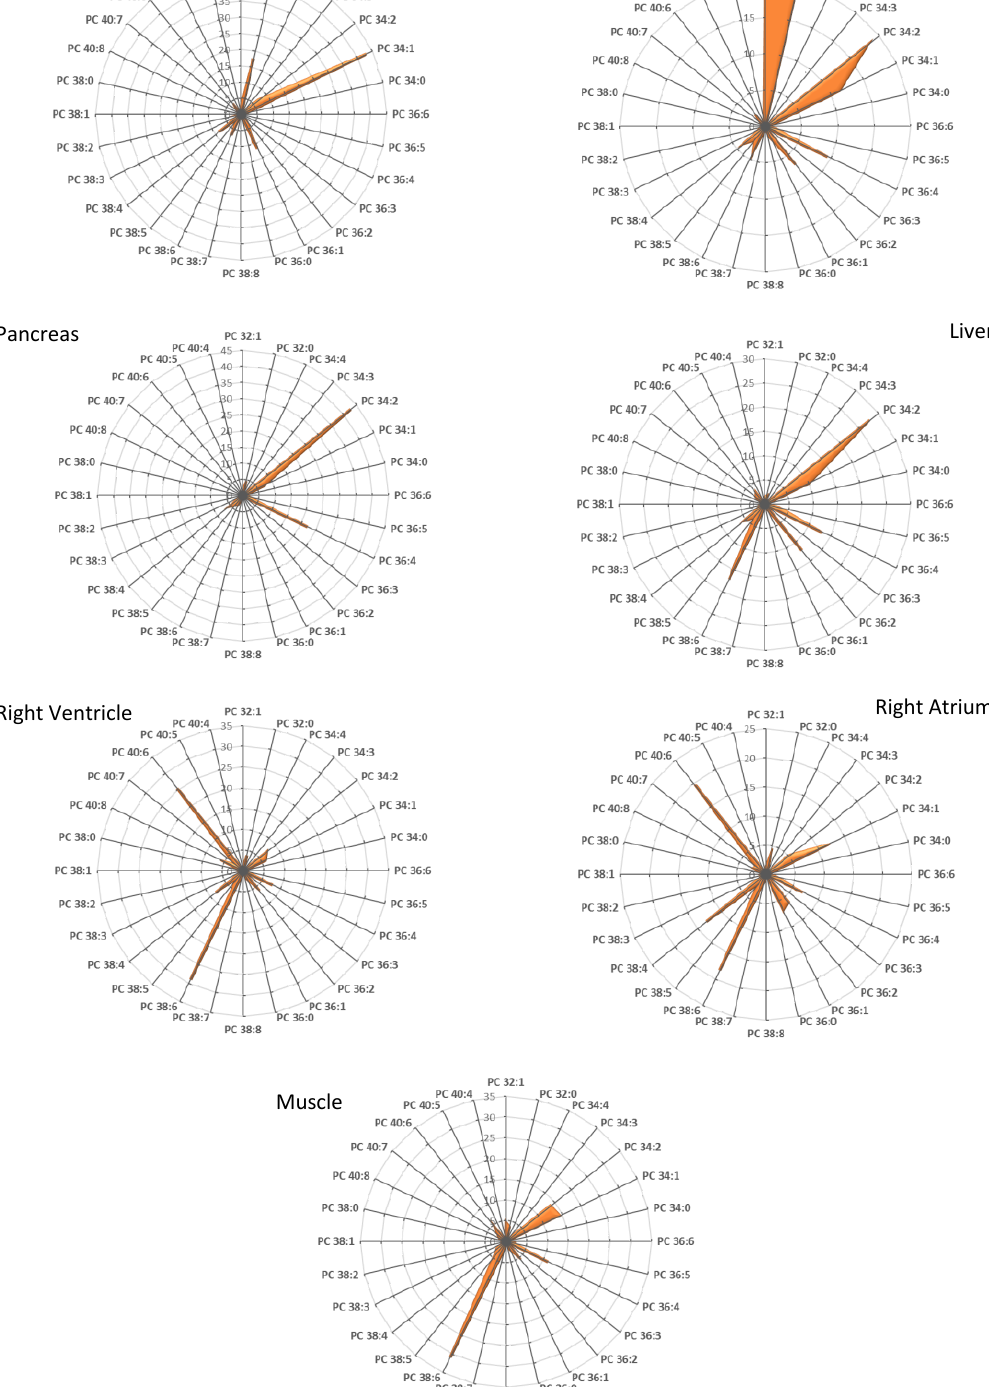
Figure 1. PC species distribution in various organs excised from mice. PC subspecies distribution in each case is displayed. The total carbon chain length (x) and number of carbon–carbon double bonds (y) in the acyl chains of the main PC molecular species (x:y) are indicated. Values are means of four independent determinations from four individuals from both groups in each case.